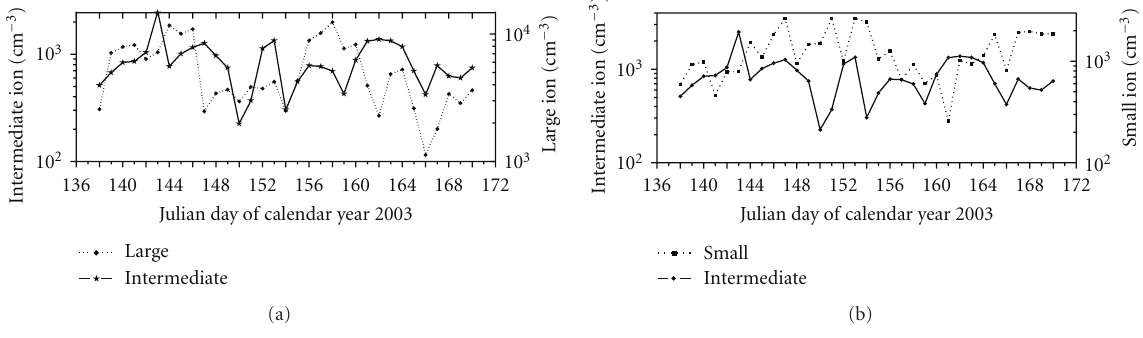
Figure 3: Daily averaged concentrations of small, intermediate, and large ions for the entire cruise